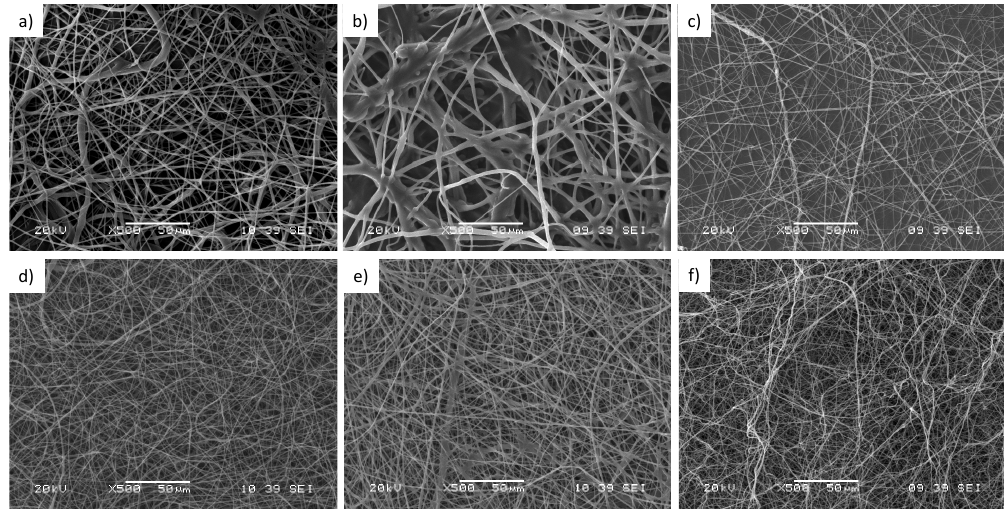
Figure 7. The effect of ( a ) Tween 80, ( b ) Tween 85, ( c ) Brij 30, ( d ) Span 20, ( e ) Span 40, and ( f ) Span 60 on the morphology of PLA nanofibers containing 0.1 w/w% Pc PAL.